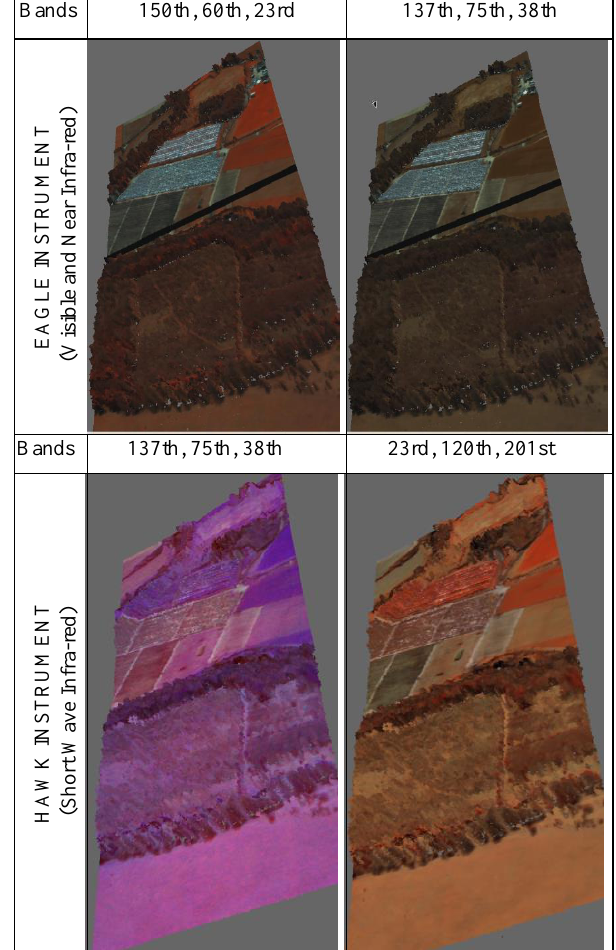
Table 5: Projecting hyperspectral images from different